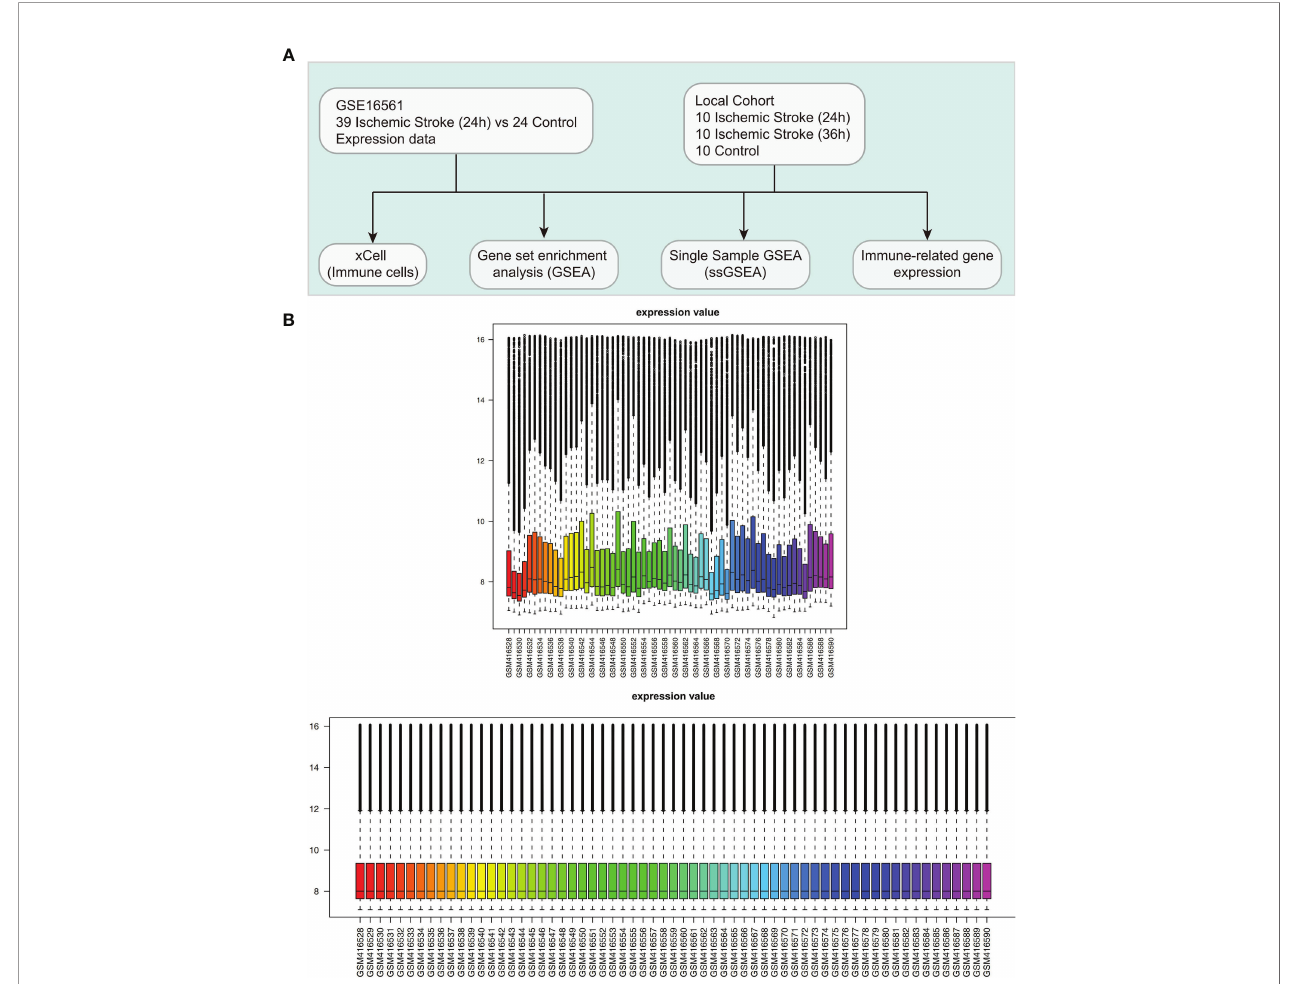
FIGURE 1 | Clinical cohort consolidation. (A) Study fl ow chart. (B) Normalization of the expression data in